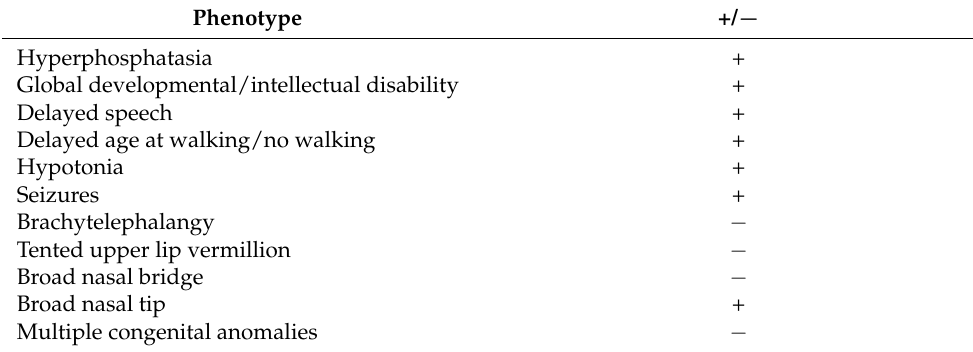
Table 1. Phenotypic spectrum of patient with features of HPMRS, Mabry syndrome (MIM: